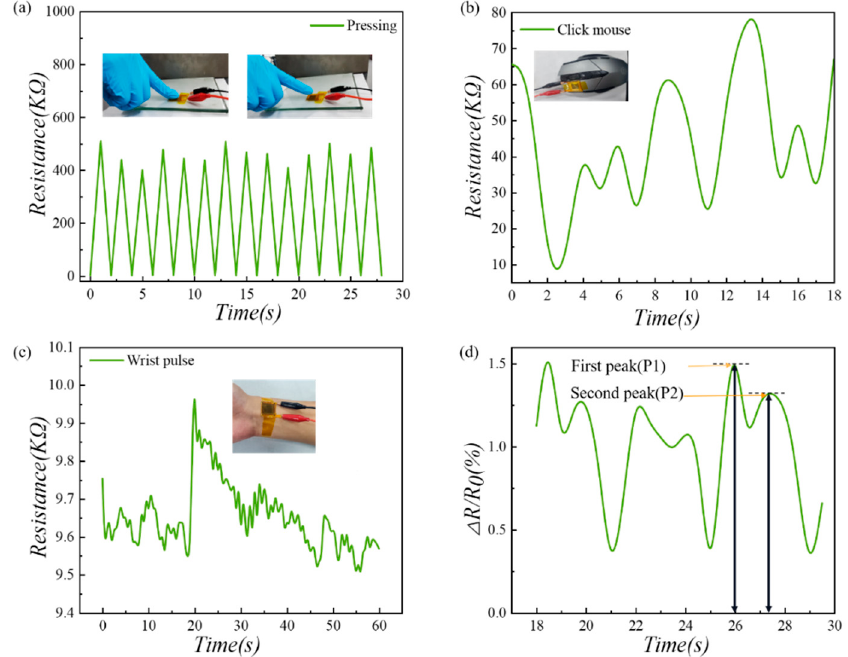
Figure 11. Applications of the batten microstructure pressure sensor in real-time monitoring of human activities: ( a ) Fingers pressing; ( b ) Mouse clicking; ( c ) Real-time pulse detecting; ( d ) Pulse vibration waveform.